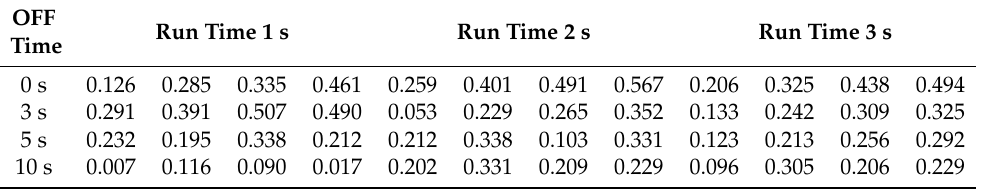
Table 3. Green frequency variation rate according to LED module ON and OFF